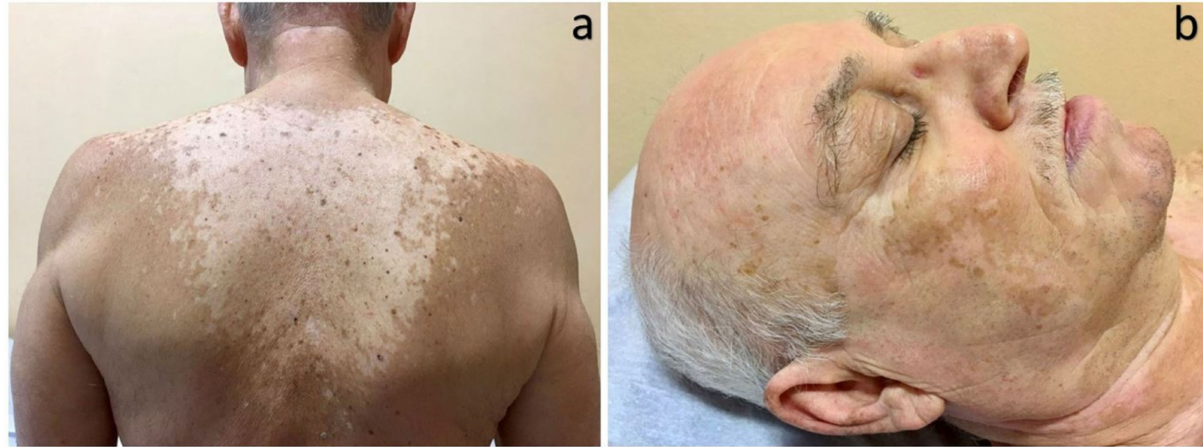
Figure 1. ( a , b ) ICI-induced vitiligo on photoexposed areas: several white dotted macules progressing toward larger